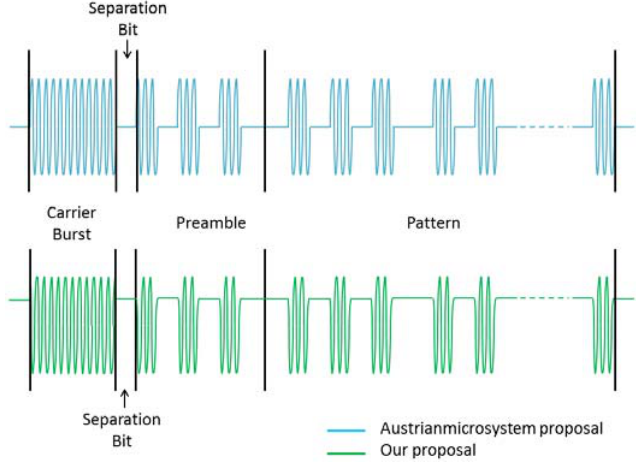
Figure 15. Transmitted signal format: AMS proposal vs. our proposal.